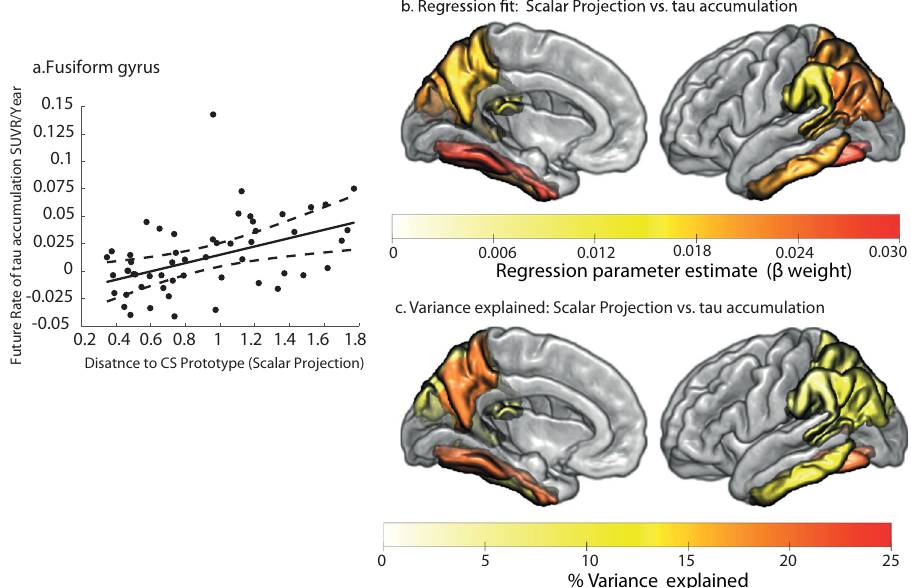
Fig. 6 Predicting individual variability in future tau accumulation in the ADNI3 Clinically Declining sample. a Regression fi t of the scalar projection with future rate of tau accumulation for the fusiform gyrus (two-tailed linear regression, p < 0.05 FWE). The central black line indicates the regression line for the regression fi t; the dashed lines indicate the 95% con fi dence intervals for this regression line. Two outliers based on the scalar projection are not shown for illustrative purposes. b Signi fi cant regional parameter estimates from linear regressions to predict future rate of tau accumulation for individuals classi fi ed as Clinically Declining (two-tailed linear regression, p < 0.05 uncorrected). The colour scale indicates the parameter estimate for the slope of the regression fi t of the scalar projection with regional future tau accumulation. c Percentage of variance explained when using the scalar projection to predict future rate of tau accumulation for individuals classi fi ed as Clinically Declining from the ADNI3 cohort. Source data are provided as a Source Data fi